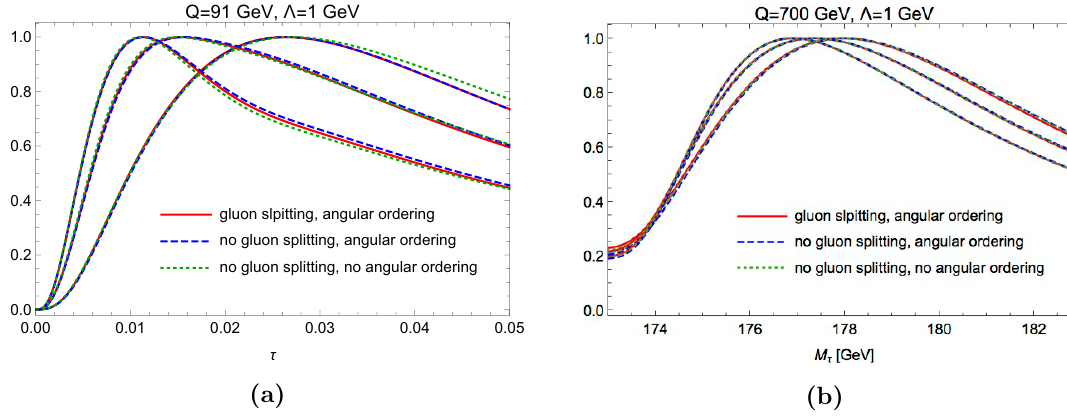
Figure 7. Thrust at the parton level in the peak region generated by Herwig 7 for (a) massless quarks at c.m. energy Q = 91 GeV and (b) top quarks with mass m t = 173 GeV at Q = 700 GeV. The Herwig 7 parton level results are smeared with a soft model shape function with smearing parameter (cid:3) = 1 GeV, see section 2.3. Displayed are simulation results for shower cuts Q 0 = 1 GeV (right set of curves), Q 0 = 1 : 5 GeV (middle set of curves) and Q 0 = 2 GeV (left set of curves) and with gluon splitting and angular ordering both turned on (solid red curves), with gluon splitting turned o(cid:11), but angular ordering turned on (dashed blue curves) and with gluon splitting and angular ordering both turned o(cid:11) (dotted green